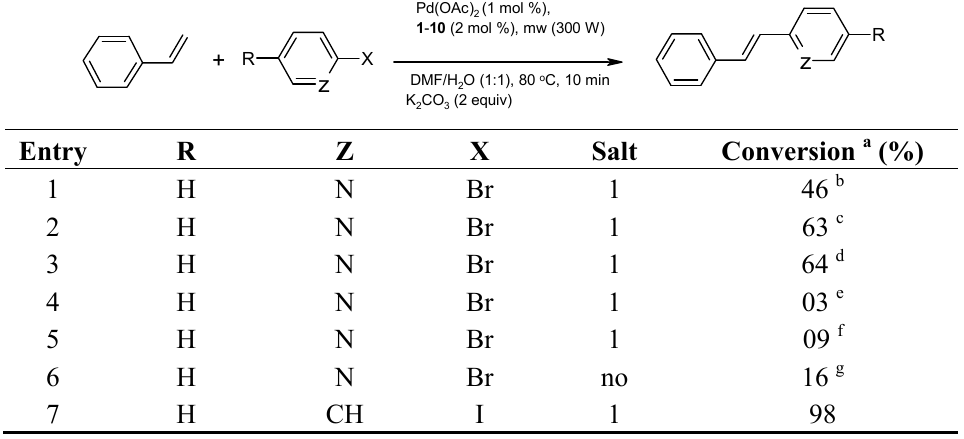
Table 2. The Heck-Mizoroki coupling reactions of aryl halides with